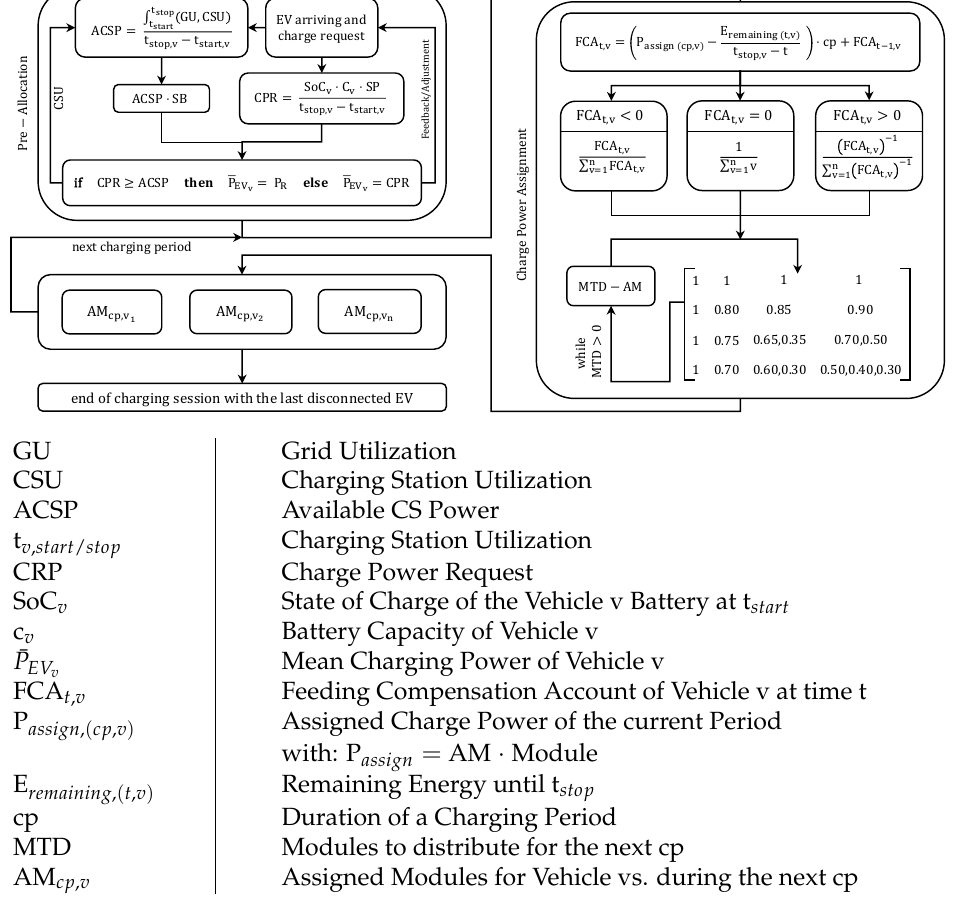
Figure 8. Load Management